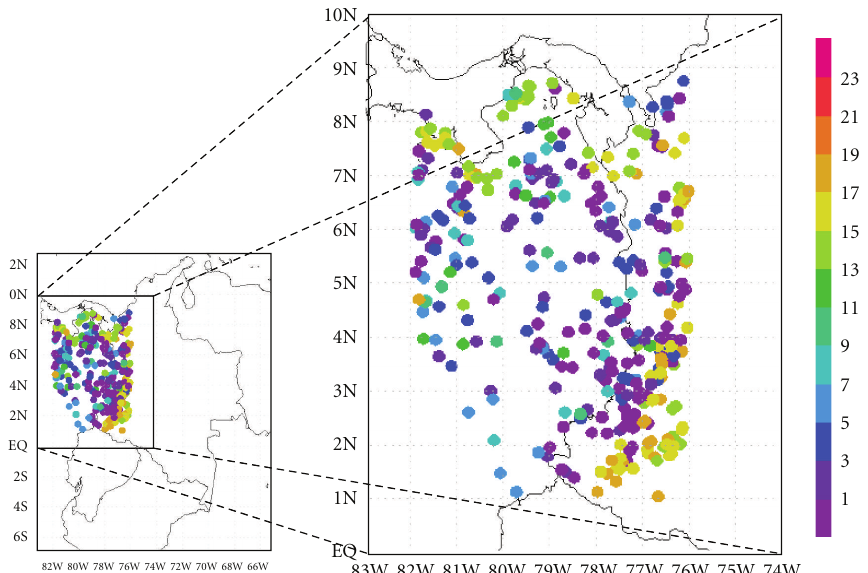
Figure 2: Mesoscale convective systems observed during 2003. Colored circles represent the position of the MCS at initial phase time (LST).